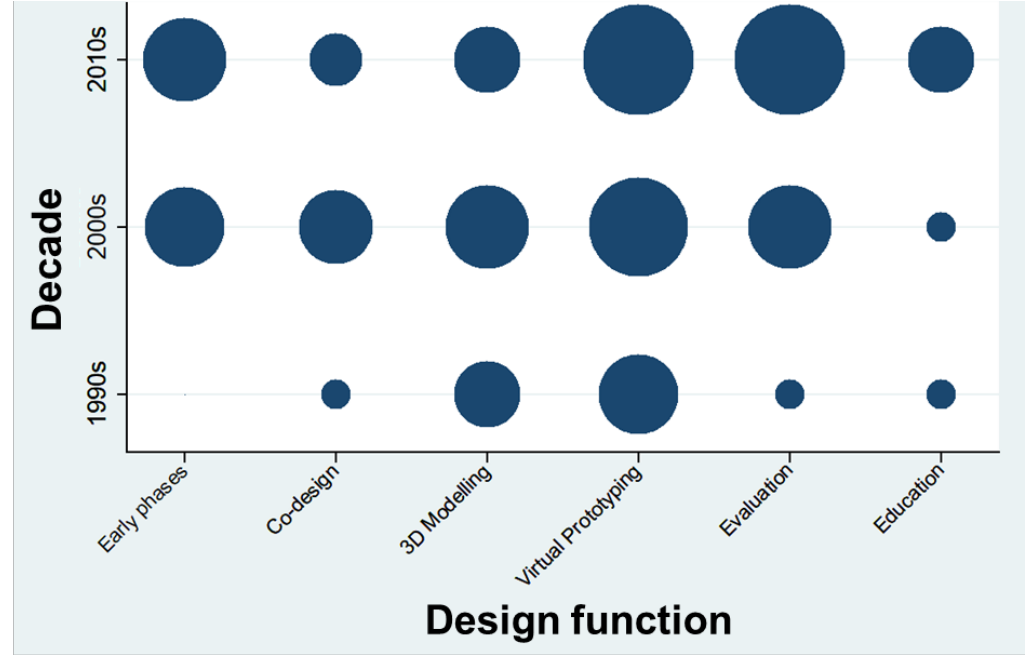
Figure 5. Number of sources illustrating specific design functions that are explicitly supported by VR technologies distributed among the last three decades.